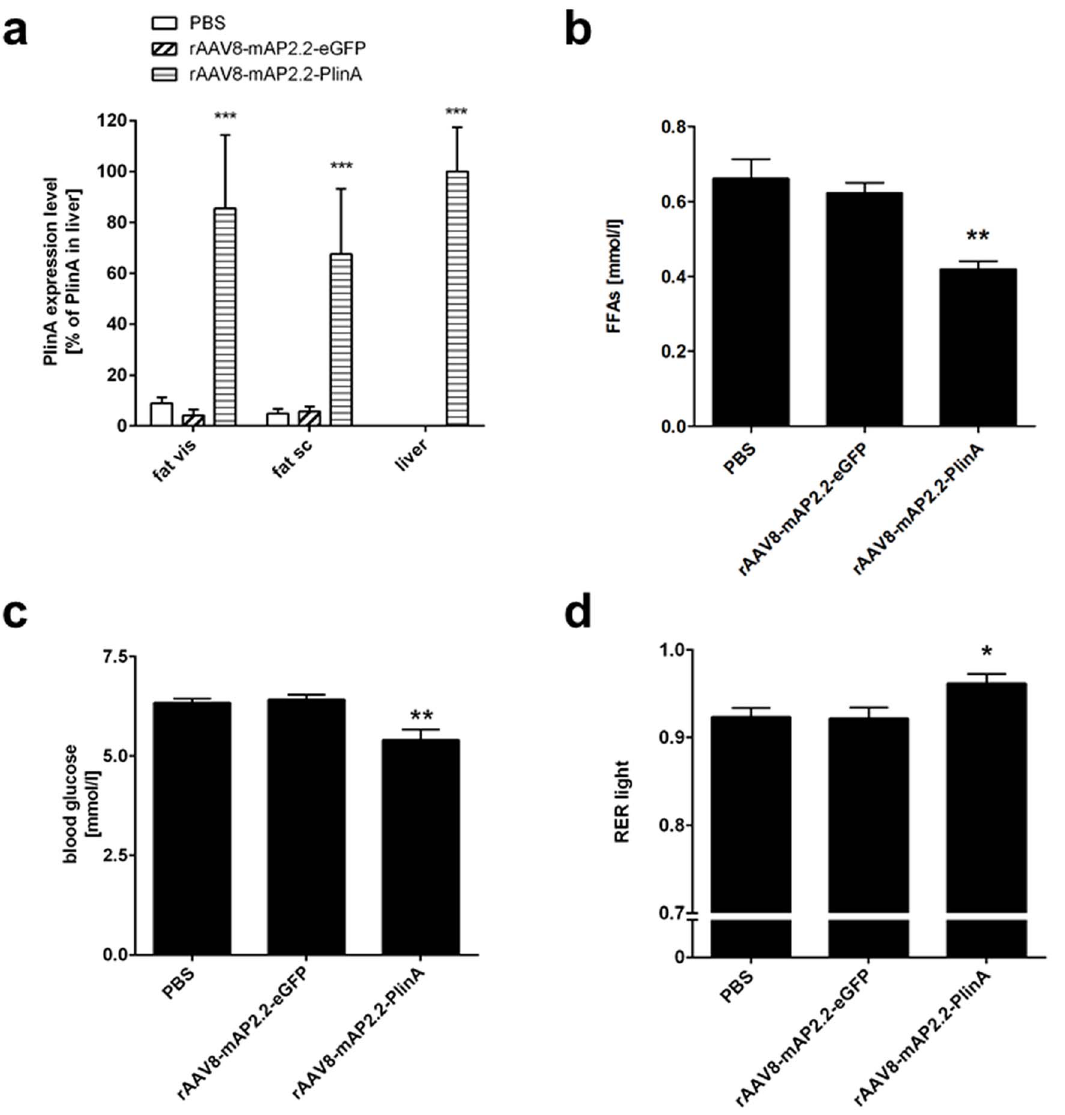
Fig. 4. Systemic application of rAAV8-mAP2.2-eGFP and rAAV8-mAP2.2-PlinA. C57BL/6 mice were injected with 10 12 VG per animal of rAAV vectors (rAAV8-mAP2.2-eGFP: hatched bars, rAAV8-mAP2.2-PlinA: striped bars) or PBS (white bars) as a mock control via the tail vein. Three weeks post application, mice were sacrificed and tissue samples from subcutaneous (sc) fat, visceral (vis) fat depots and liver were taken. (a) Transgenic PlinA expression levels were determined by qPCR. Gene expression data were normalized to RNA-pol-II and the mean of the target/reference ratio calculated for liver samples of the rAAV8-mAP2.2-PlinA group was set to 100%. (b–c) Serum levels of free fatty acids (b) and blood glucose (c). (d) Respiratory exchange ratio (RER): results are illustrated within the physiologically relevant window of 0.7 to 1.0. Values indicate the mean of at least three animals, error bars show SEM. *** P , 0.001; ** P , 0.01 and * P ,